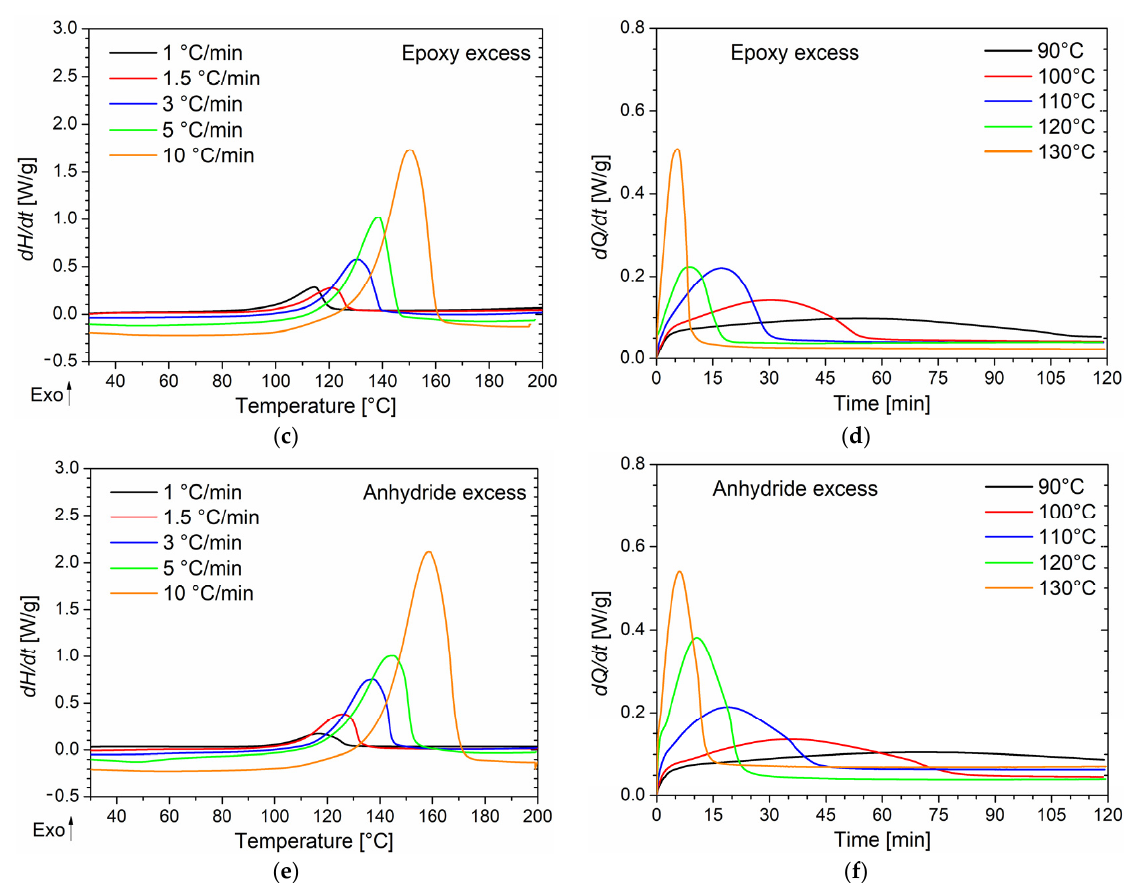
Figure 1. Non ‐ isothermal DSC thermograms of BOMF/MNA resins with ( a ) a stoichiometric epoxy/anhydride ratio, ( c ) epoxy excess, and ( e ) anhydride excess. Dynamic DSC analyses were conducted at five heating rates (i.e., 1 °C/min, 1.5 °C/min, 3 °C/min, 5 °C/min, and 10 °C/min) for each sample. Isothermal DSC thermograms of BOMF/MNA resins with ( b ) a stoichiometric epoxy/anhydride ratio, ( d ) epoxy excess, and ( f ) anhydride excess at five different temperatures (i.e., 90, 100, 110, 120, and 130 °C) for each sample. Table 1. Peak temperature ( T p ) values for the non ‐ isothermal DSC analyses at different heating rates for mixtures with balanced and unbalanced epoxy/anhydride ratios. 10 °C/min 5 °C/min 3 °C/min 1.5 °C/min 1 °C/min Stoichiometric 158.4 °C 145.6 °C 136.7 °C 126.1 °C 119.0 °C Epoxy Excess 153.1 °C 140.7 °C 130.8 °C 120.9 °C 114.5 °C Anhydride Excess 158.3 °C 144.9 °C 137.3 °C 125.9 °C 116.7 °C